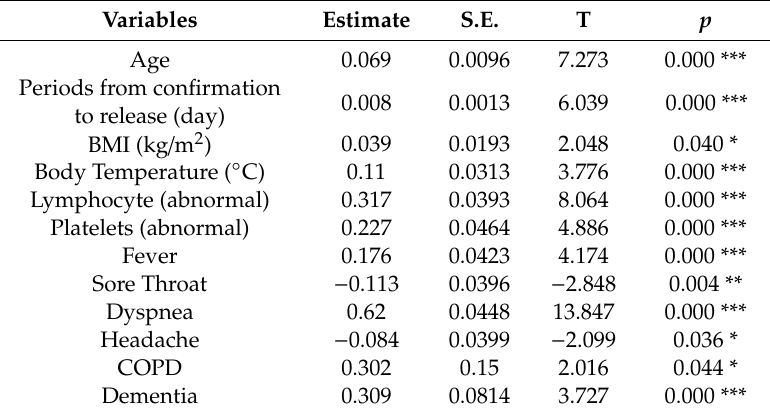
Table 2. Multiple Regression for Risk on the Severity of